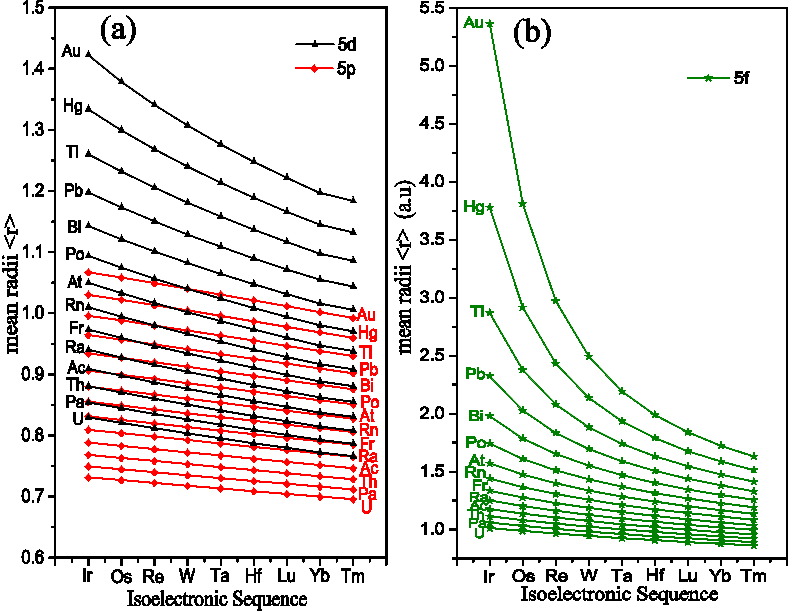
Figure 3. (Color online) mean radii of 5p , 5d , and 5f eigenfunctions for ions of the Ir (ground state 5d 9 ) through Tm (ground configuration 5d 1 ) for all elements from Au-U. through Tm (ground configuration 5d 1 ) for all elements from